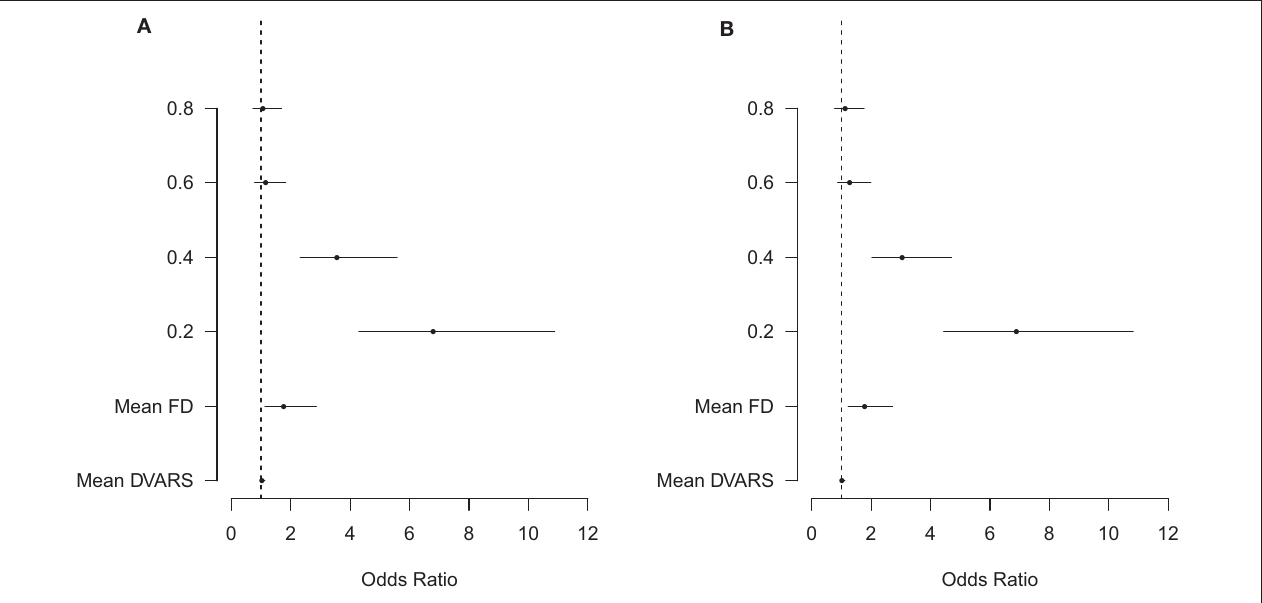
FIGURE 6 | Visualization of the results of the ordinal mixed models of the association between several predictors and BOLD delay map noisiness (A) and structure clarity (B) . The points represent the odds ratios and the lines represent the 95% confidence intervals of the odds ratios for each predictor. The vertical dashed line represents an odds ratio of 1. FD, framewise displacement. The scan lengths are shown as 0.8, 0.6, 0.4, and 0.2 with the full scan used as the reference category. The plot shows that head motion (mean FD and mean DVARS) as well as the shortened 0.4 and 0.2 scans are associated with a significantly higher odds of more noise and less structure clarity than full scans. Note that only a subset of the predictors in this model are shown here—the numerical results of this ordinal mixed model, including the rest of the predictors, are shown in Supplementary Table 4 (noisiness) and 5 (structure